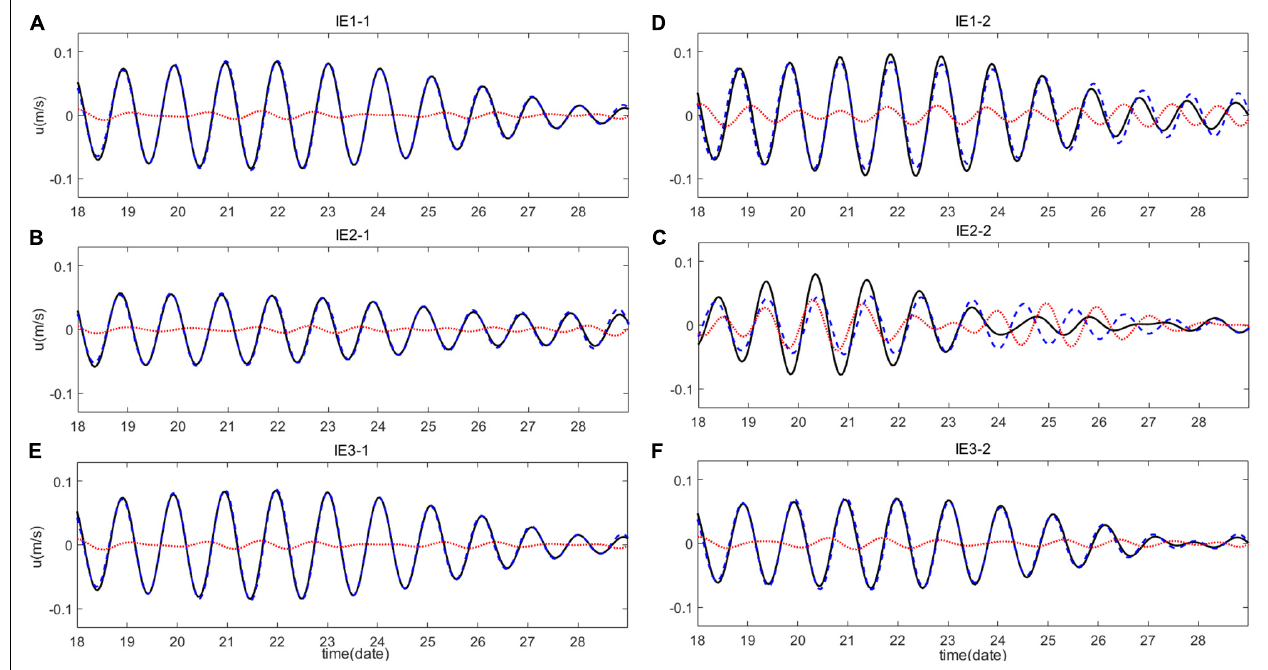
FIGURE 9 | Eastward velocities of diurnal baroclinic tides (black solid line), coherent signals (blue dashed line), and incoherent signals (red dot line) at the depth of 100 m for experiments in (A,B) IE1, (C,D) IE2, and (E,F) IE3 at site C.